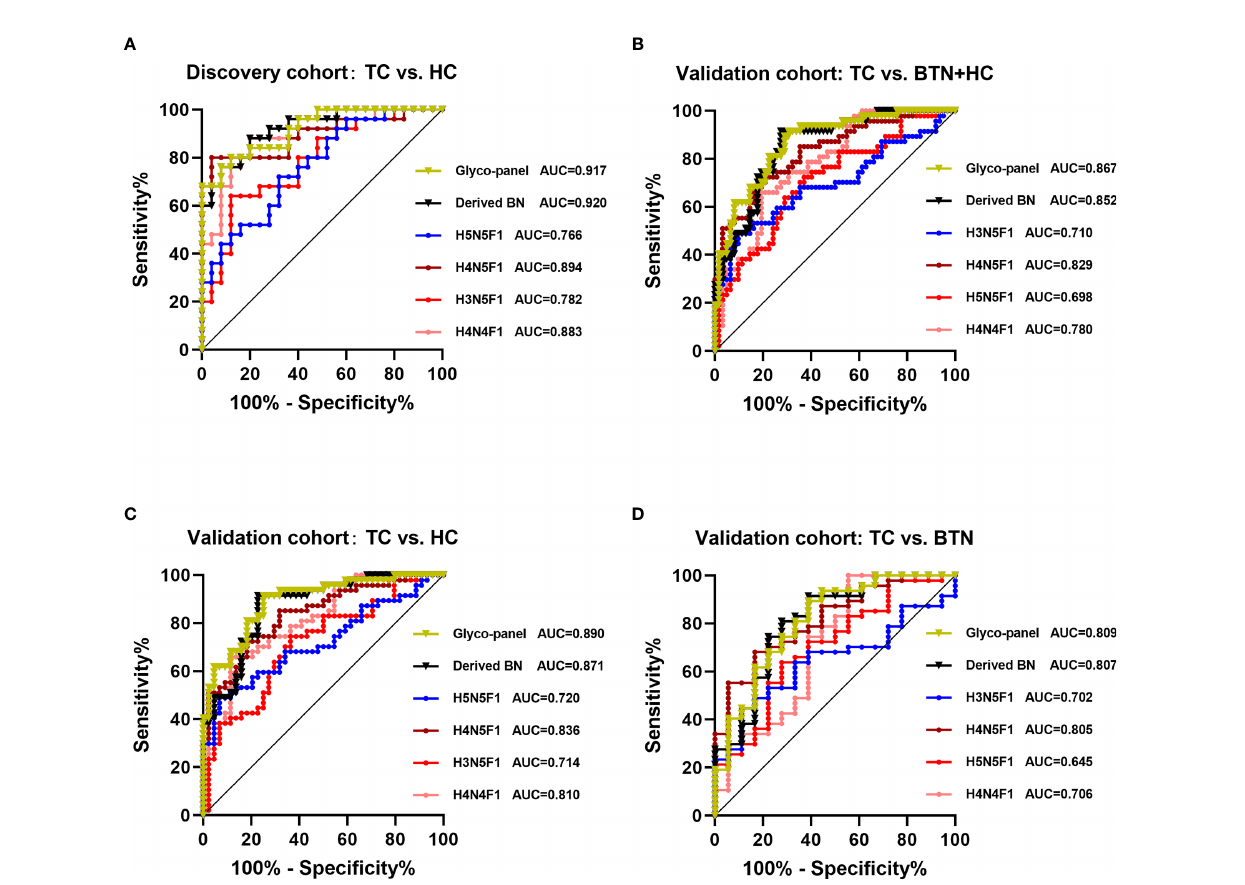
FIGURE 4 | ROC curve analysis for differential expressed IgG glycan traits and a glyco-panel built based on altered single glycan traits (A) in the discovery cohort and (B – D) in the validation cohort. In the discovery cohort, we performed analysis between TC and HC. In the validation cohort, we performed analysis among three subgroups (TC vs . HC+BTN, TC vs . HC, TC vs . BTN). TC, thyroid cancer; HC, healthy controls; BTN, benign thyroid